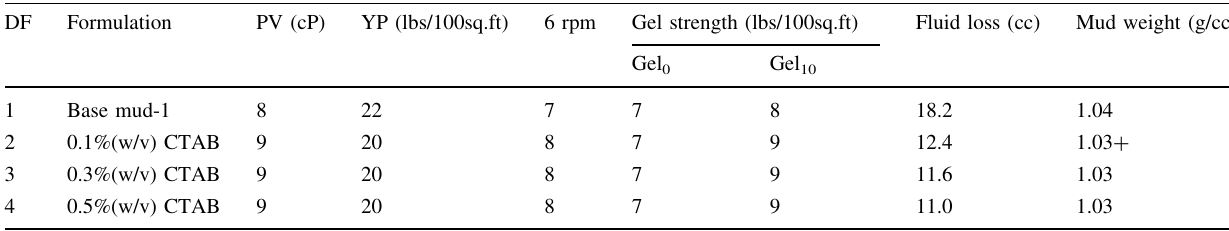
Table 5 Performance study of CTAB on KCl-inhibited polymer mud system DF Formulation